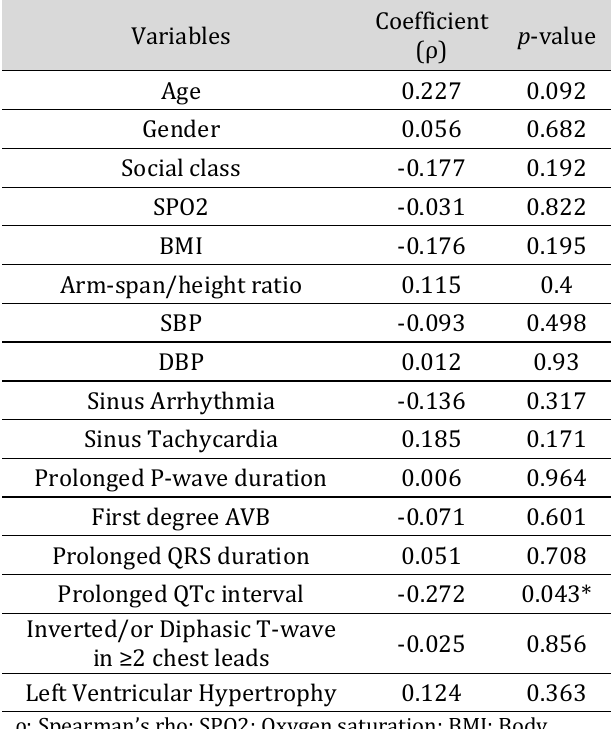
Table 5. Correlation of clinical and ECG findings with SCA disease severity in the 56